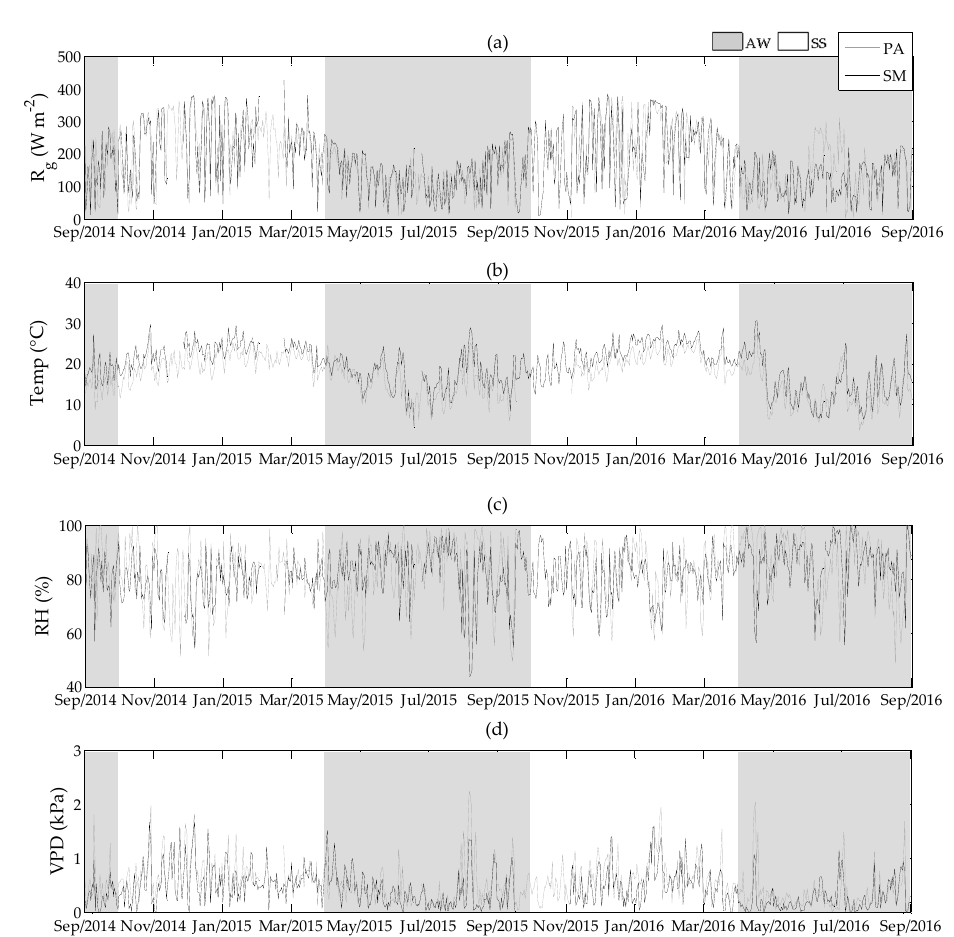
Figure 2. Daily values of meteorological variables: ( a ) Global Radiation—R g (W m − 2 ), ( b ) Air Temperature—Temp (°C), ( c ) Relative Humidity—RH (%), and ( d ) Vapor Pressure Deficit—VPD (kPa). The hatched areas indicate the autumn–winter (AW) periods.